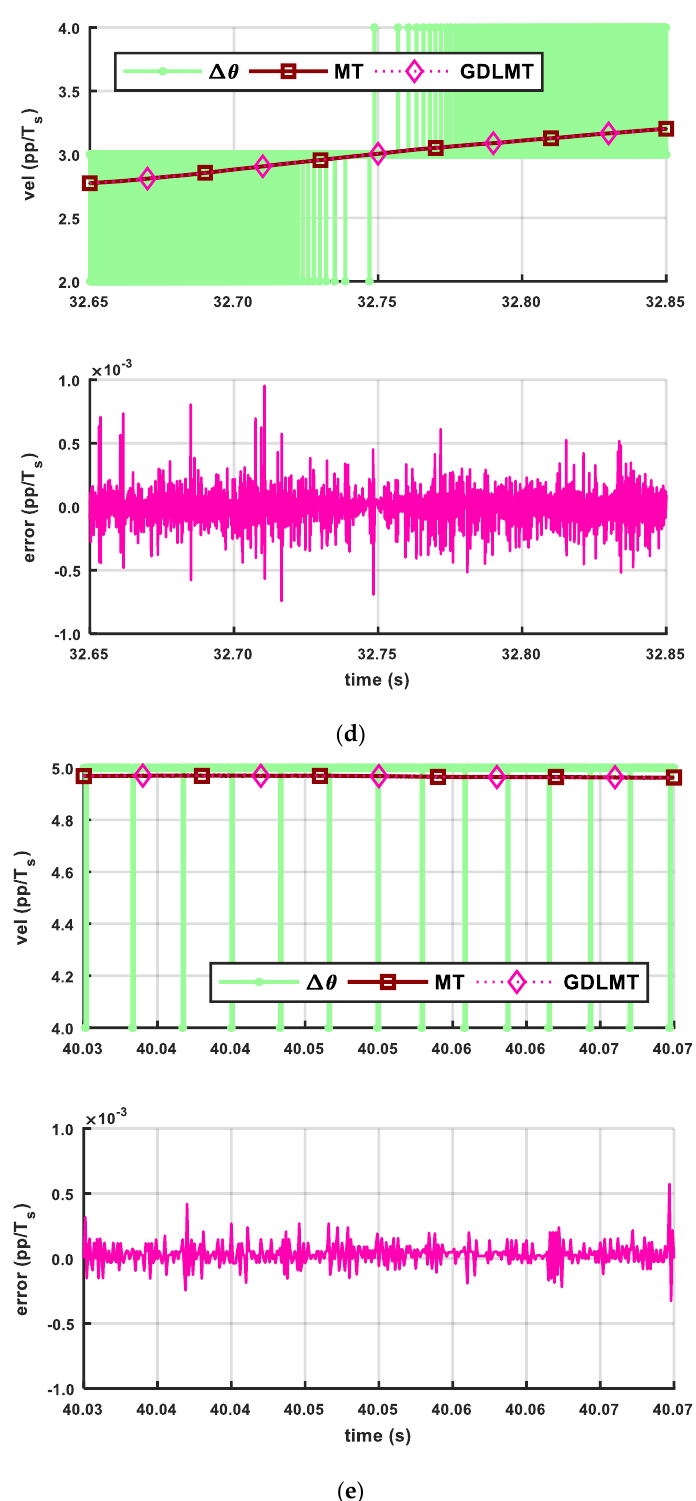
Figure 11. Comparison of the MT method and the GDLMT method at medium speed: ( a ) full time interval; ( b ) detail 1 with velocity overshoot (peak velocity); ( c ) detail 2 with velocity zero crossing; ( d ) detail 3 with ramp velocity (constant acceleration), and ( e ) detail 4 with constant velocity.